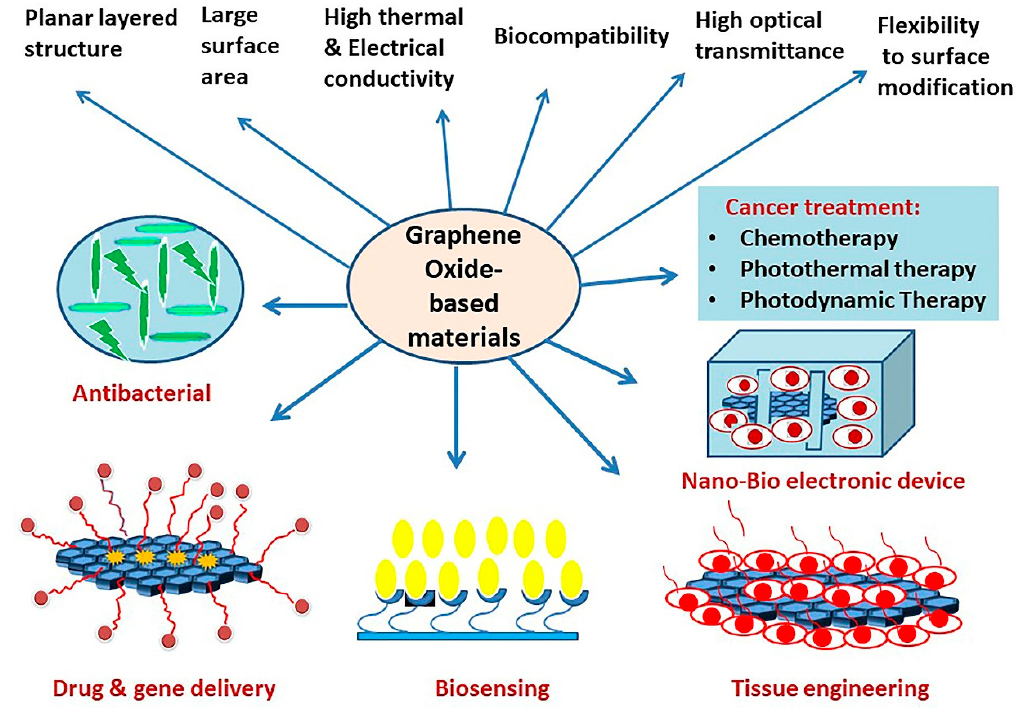
Figure 5. The figure illustrates important properties of graphene oxide (GO) and biomedical applications of GO ‐ based nanomaterials and